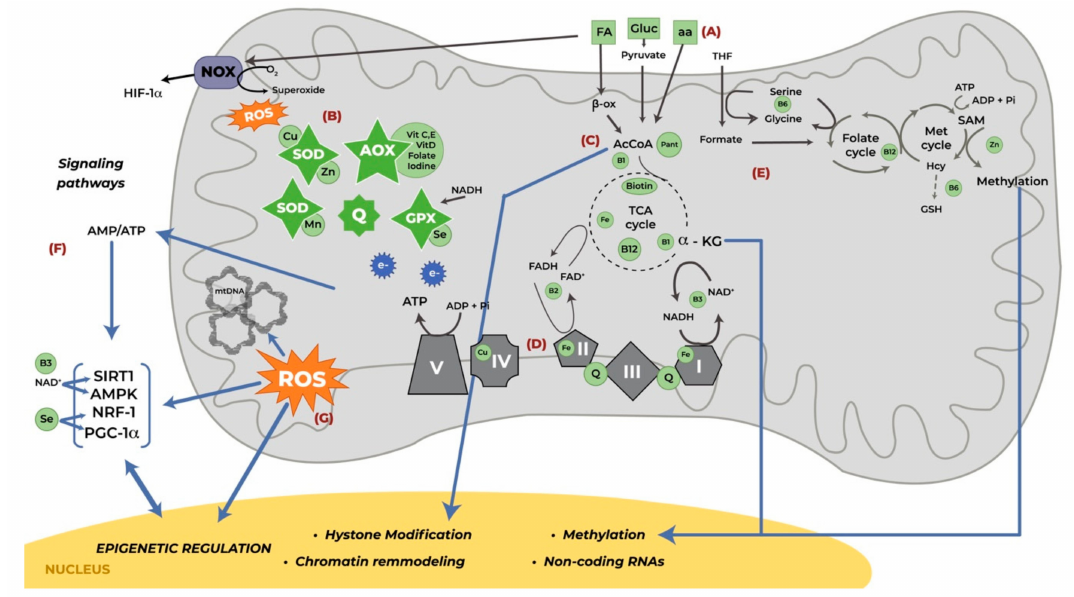
Figure 1. Nutrients involved in mitochondrial function which may influence perinatal outcomes. ( A ) Excessive substrate consumption could increase ROS production. ( B ) Micronutrients are part